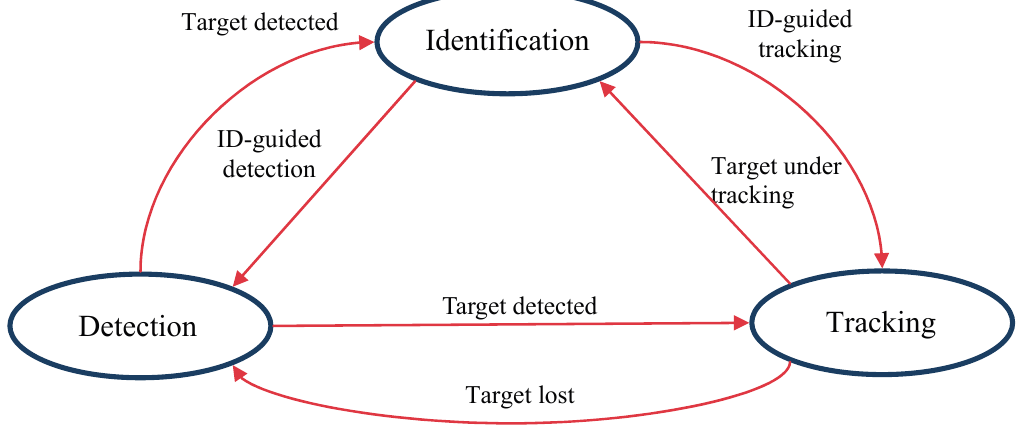
Figure 6. Cooperation among detection, tracking, and identification modules.